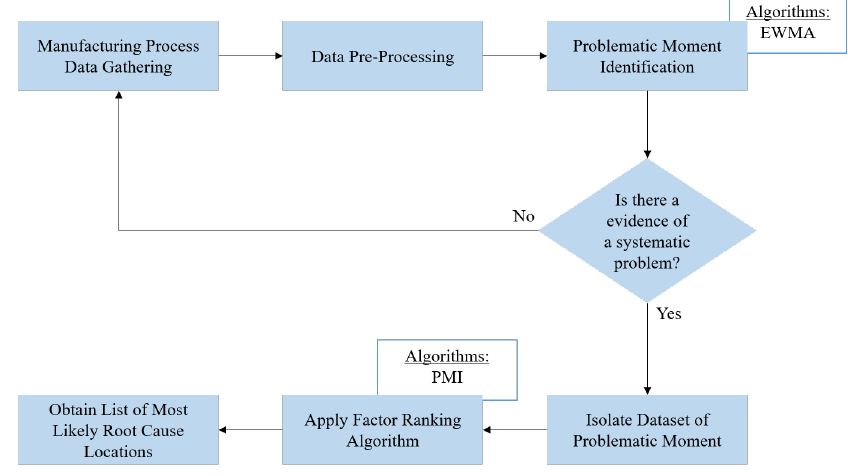
Figure 2. Illustration of the proposed ARCA